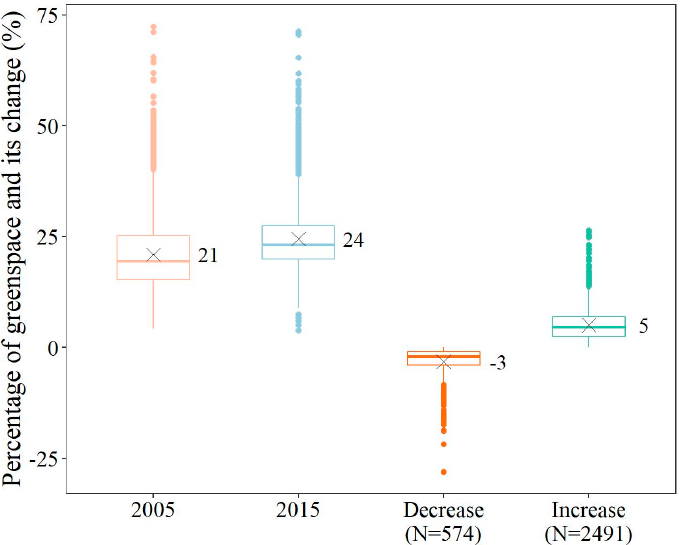
Figure 6. Accessible greenspace and its change in the 3065 neighborhoods. We define accessible greenspace as the percentage of greenspace within a 500 m buffer along the boundary of each neighborhood. The two boxplots on the left represent accessible greenspace in 2005 and 2015 with average values of 21% and 24%, respectively. The two boxplots on the right represent the change in accessible greenspace from 2005 to 2015, which decreased in 574 neighborhoods by 3% and increased in 2491 neighborhoods by 5%.